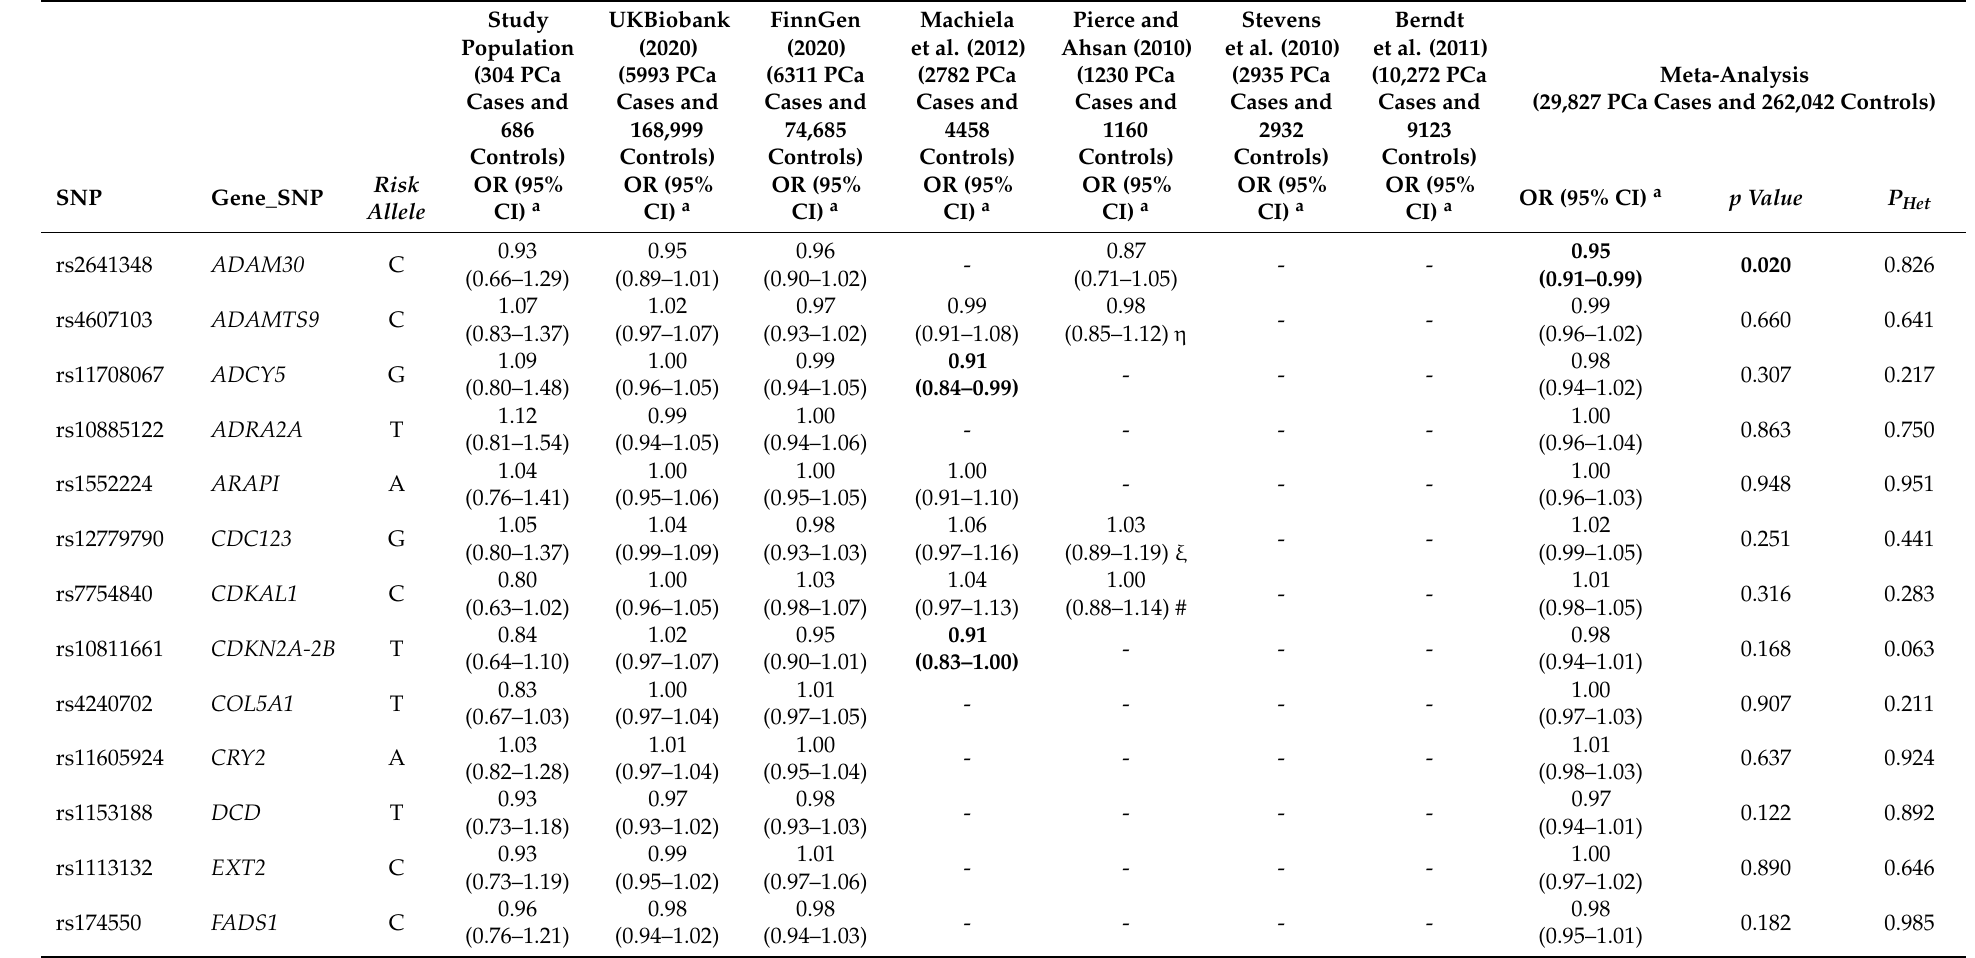
Table 4. Meta-analysis of association estimates with previous candidate gene association studies according to a log-additive model of